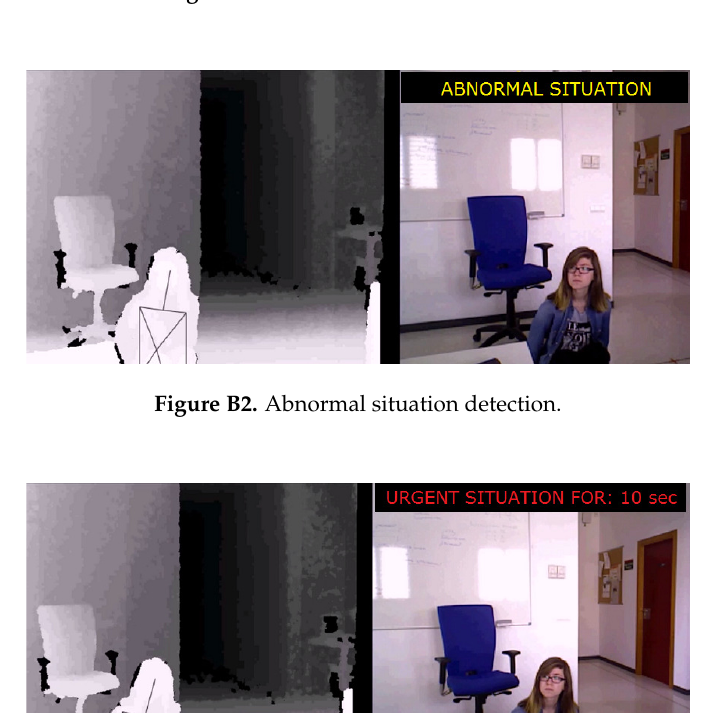
Figure B1. Normal situation detection.